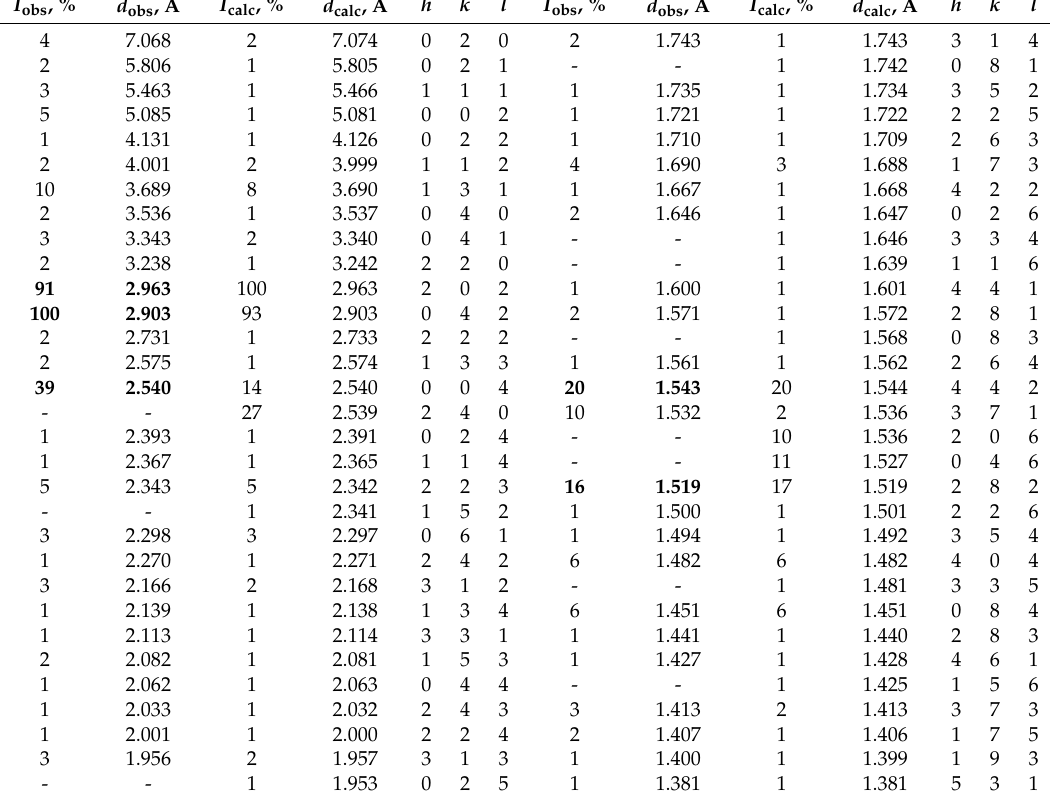
Table 4. Powder X-ray diffraction data for the holotype specimen of